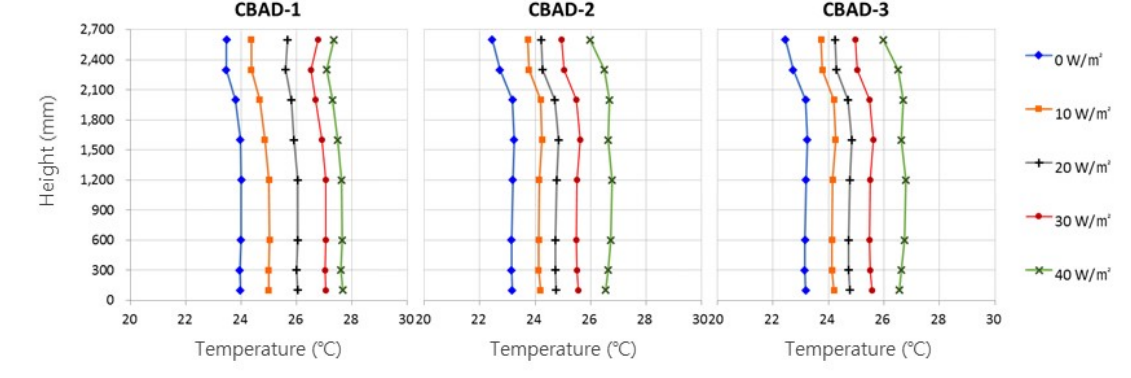
Figure 17. Vertical temperature distribution at (X1, Y3), CBAD.